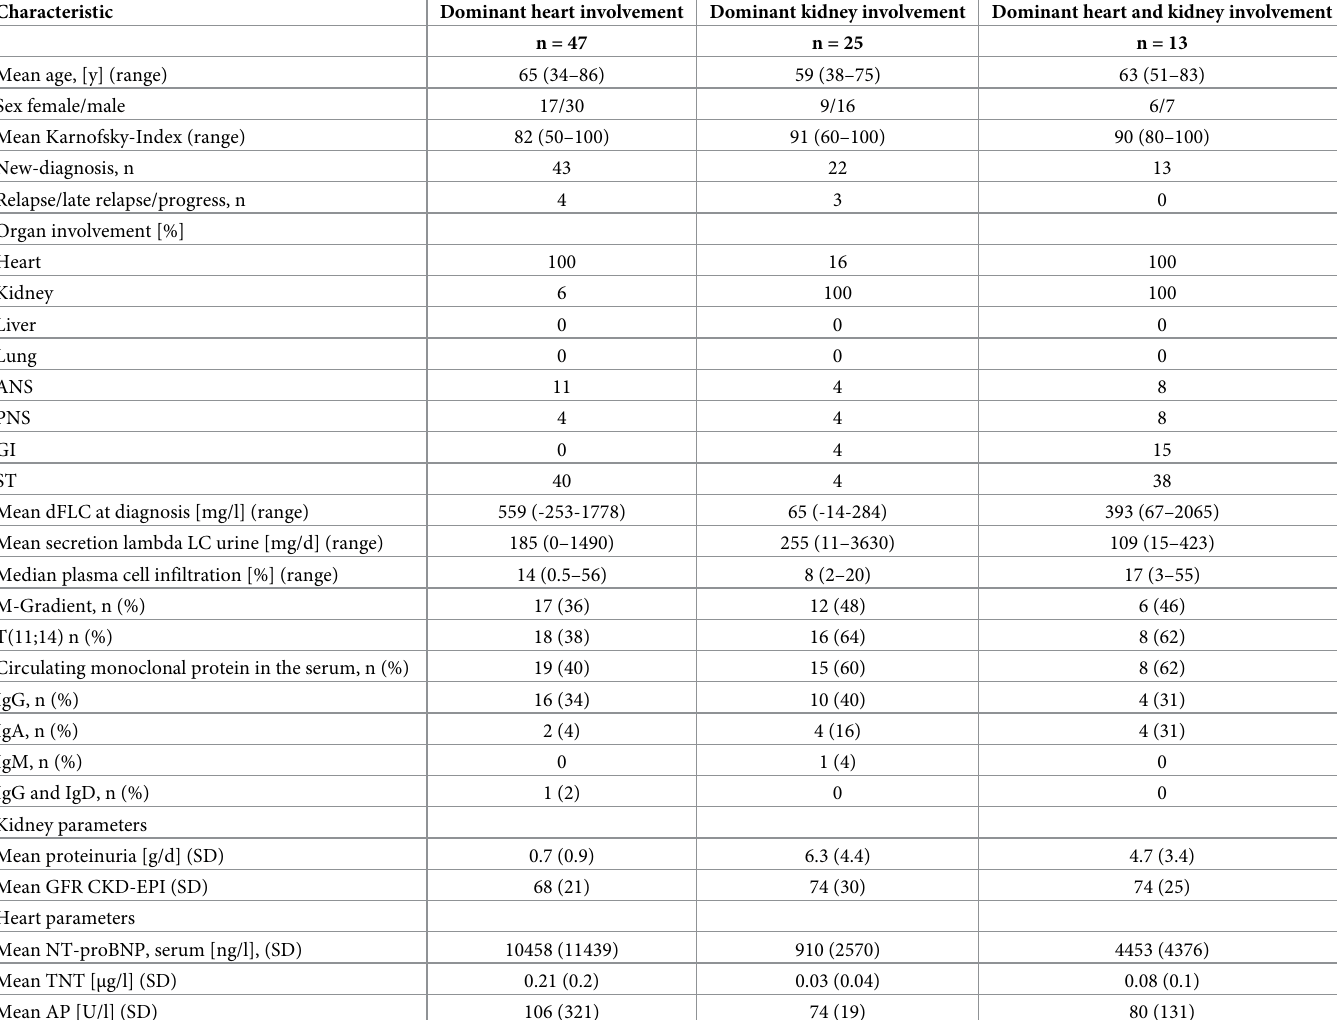
Table 2. Characteristics of 85 patients with AL amyloidosis were included in this